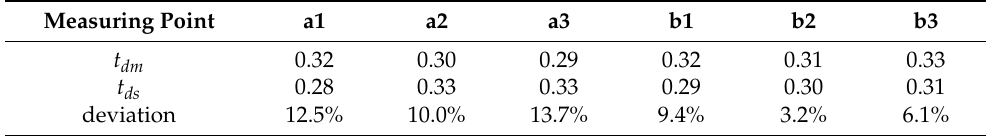
Table 5. Comparisons between CFD results and the measured